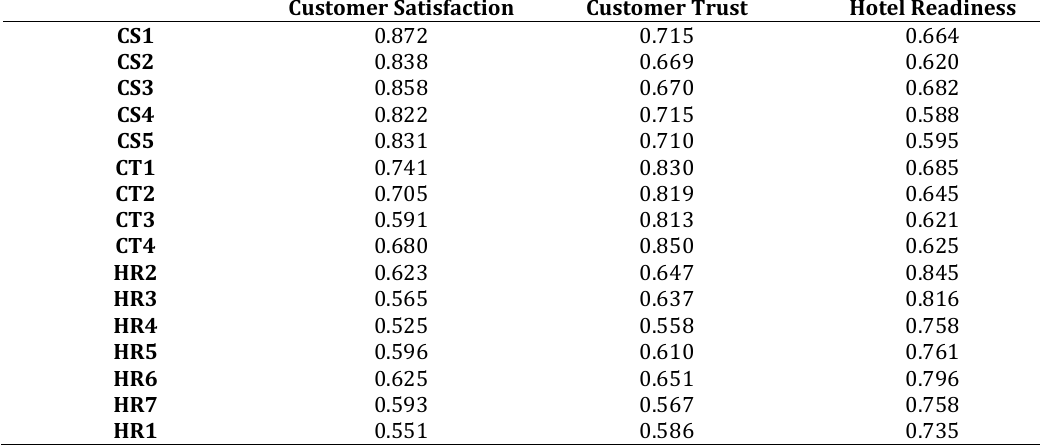
Table 7: Cross loading for local chain hotels Customer Satisfaction Customer Trust